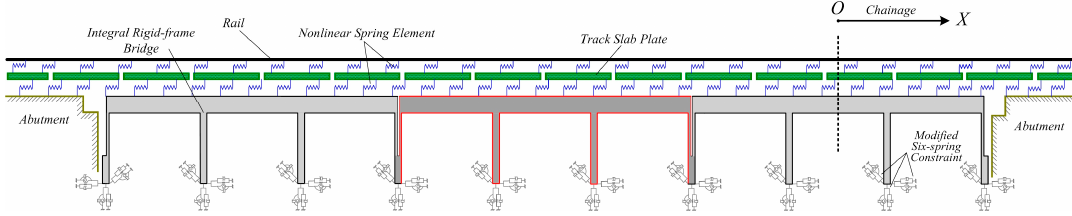
Figure 6. Sketch drawing of the calculating model of track–bridge interaction for an integral rigid-frame bridge.